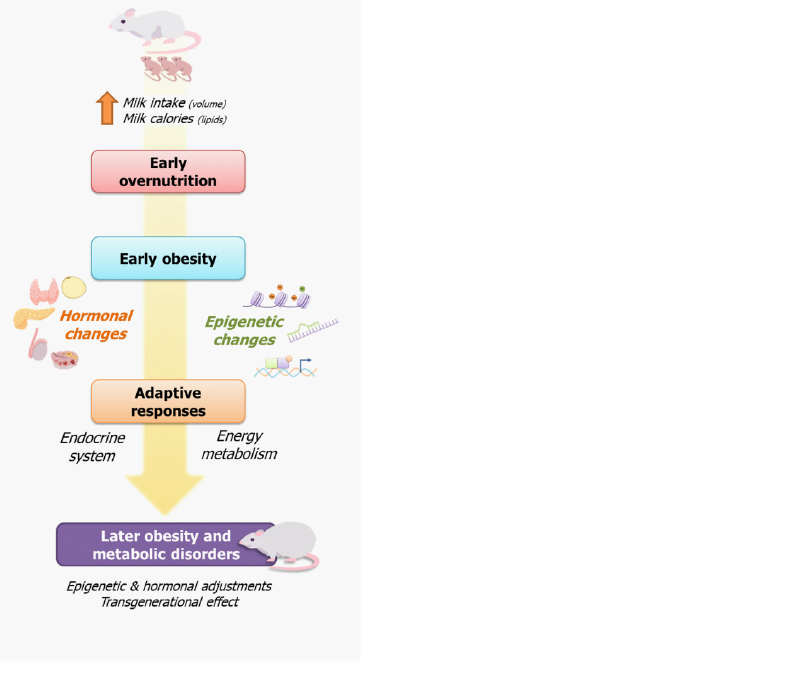
Figure 1. Early overnutrition triggers adaptive responses of the endocrine system and energy metabolism leading to the obesity phenotype of the small litter model. Early overnutrition is a result of increased volume and calorie intake during the lactation period, resulting in early obesity. In response to this early metabolic overload, adaptive responses arise, involving the endocrine system and energy metabolism, which contribute to obesity and metabolic disorders in adult life in offspring raised in small litters.